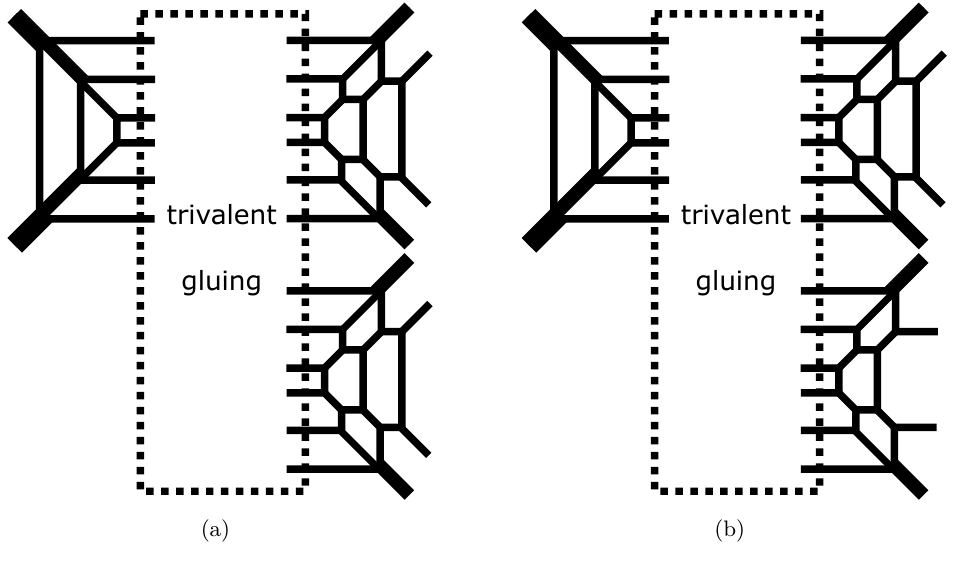
Figure 37. (a). The web diagram for the 6d theory given by e (1) diagram for 5d E 6 gauge theory with 4 flavors.